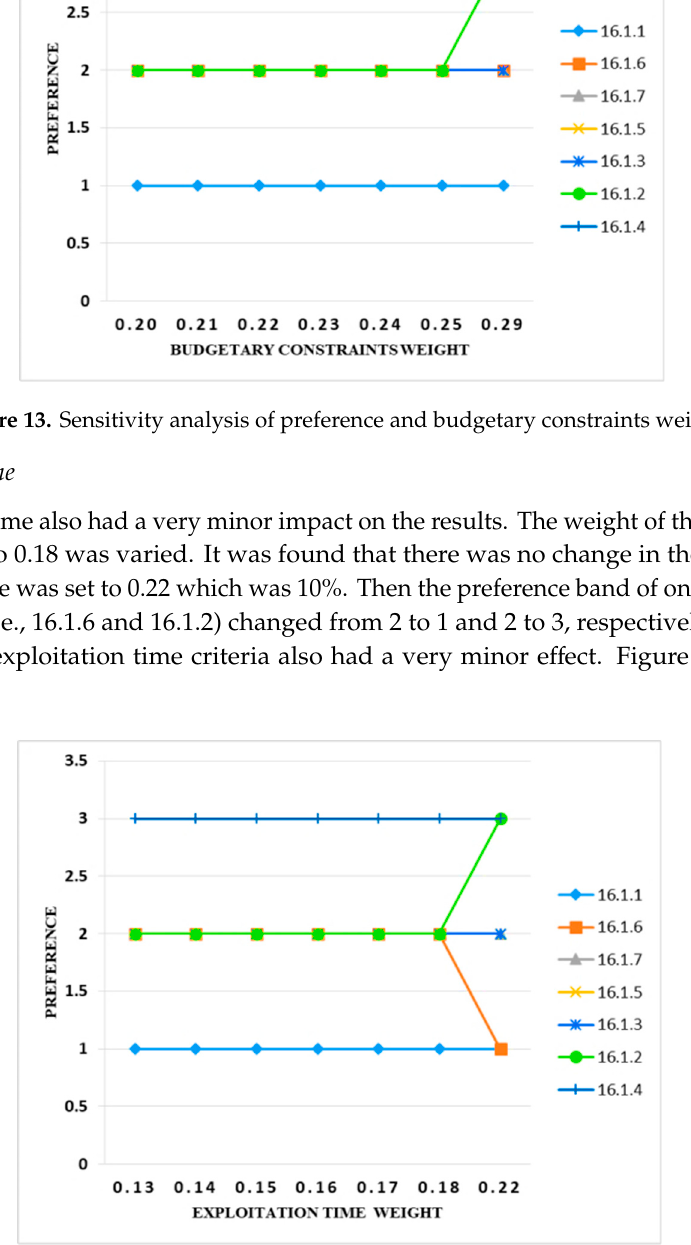
Figure 12. Sensitivity analysis of preference and risk weight.